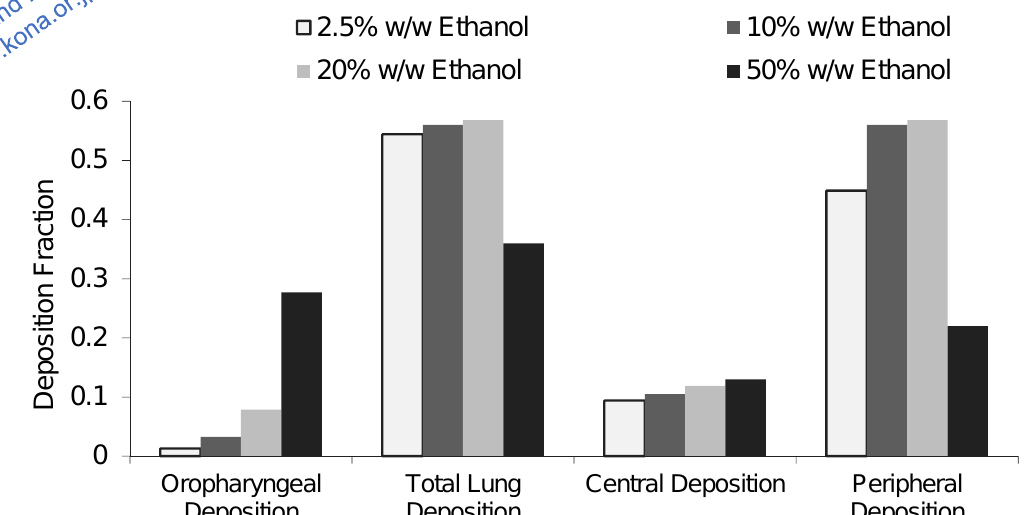
Fig. 4 Predicted deposition patterns for the four different HFA –ethanol formulations obtained using in vitro sizing data.